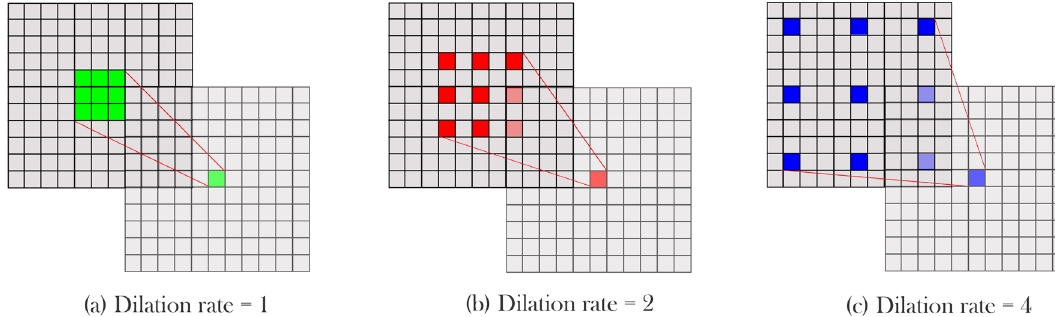
Figure 3. Dilated convolution visualization. Dilated convolution kernels presented with dilation rates ( a ) 1, ( b ) 2, and ( c ) 4. Increasing the dilation rate increases the kernel’s field of view.